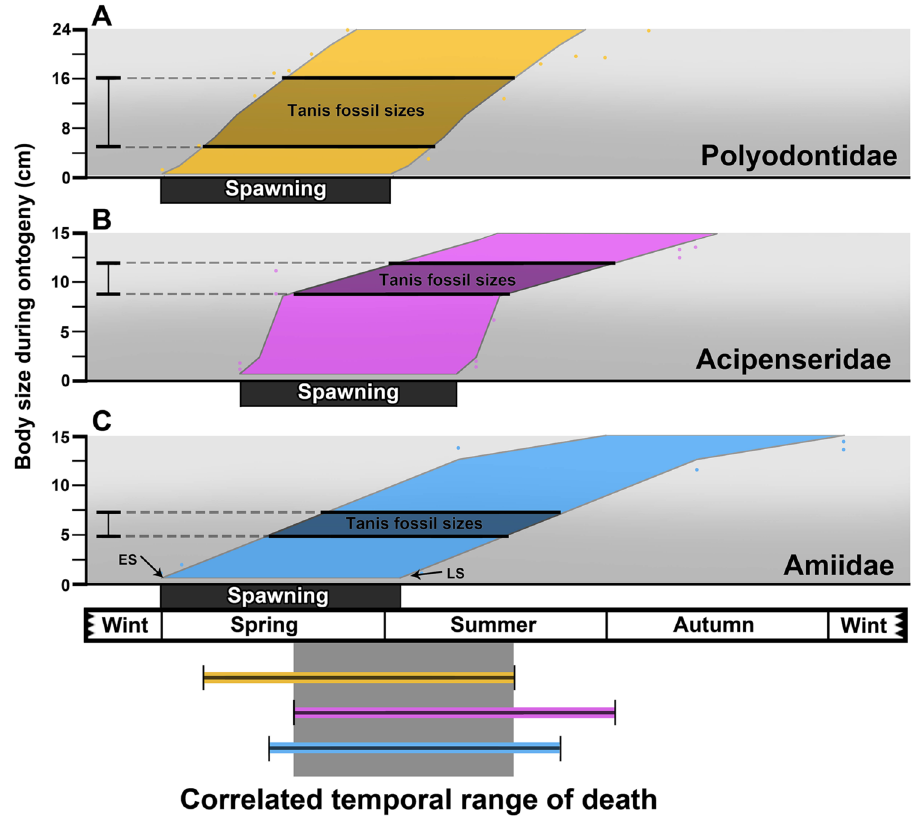
Figure 3. Estimated chronology of death for Tanis sub-yearling fish. A-C, compiled ranges of body sizes for modern fish taxa (Polyodontidae, Acipenseridae, Amiidae) 12,14–16,30,31,39,43–45 relative to time span after spawning. Bracketing this growth data between early spawning (ES) and late spawning (LS) starting points gives a full spectrum of possible seasonal end-points relative to a given body size (shaded region). The Tanis specimens broadly ranged between early-mid Spring and late Summer. The correlated overlapping regions refined this further, identifying the time of death as late Spring to